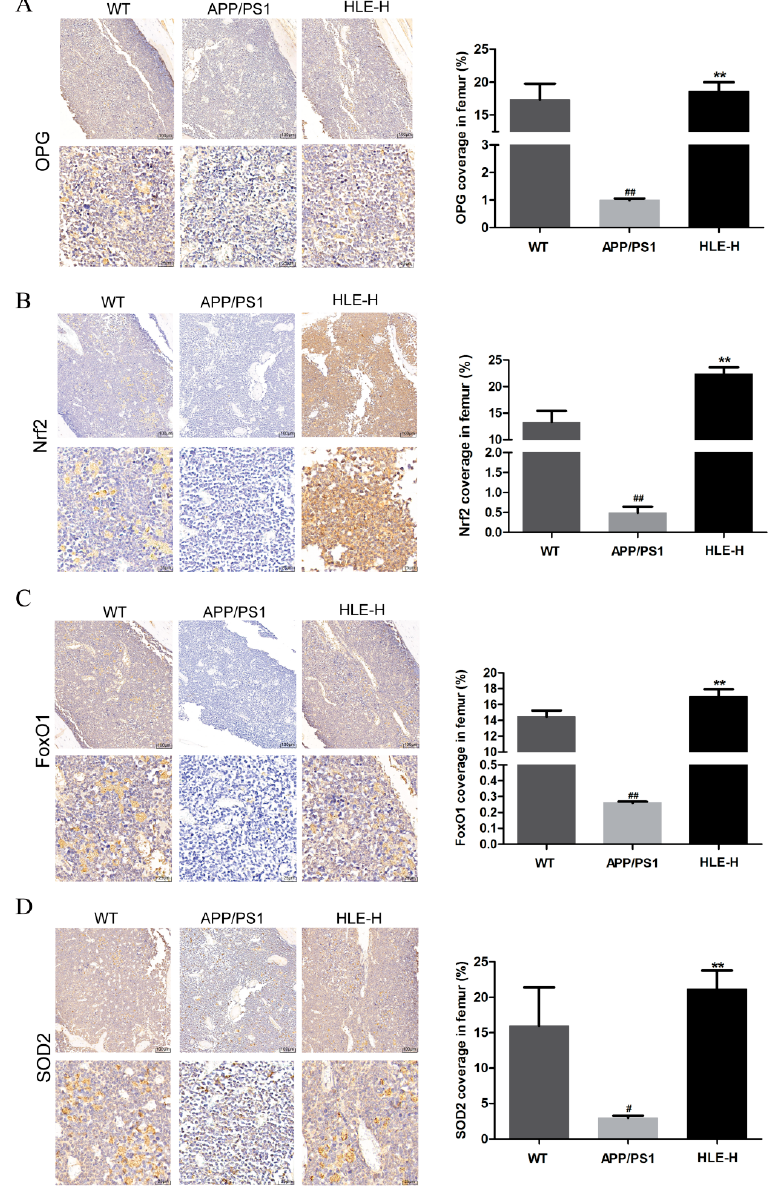
Figure 5. Effects of HLE on ( A ) OPG; ( B ) Nrf2; ( C ) FoxO1; and ( D ) SOD2 expression in femurs of APP/PS1 mice by immunohistochemistry ( n = 3). (# p < 0.05, ## p < 0.01, compared with the WT group; ** p < 0.01 compared with the APP/PS1 group.)